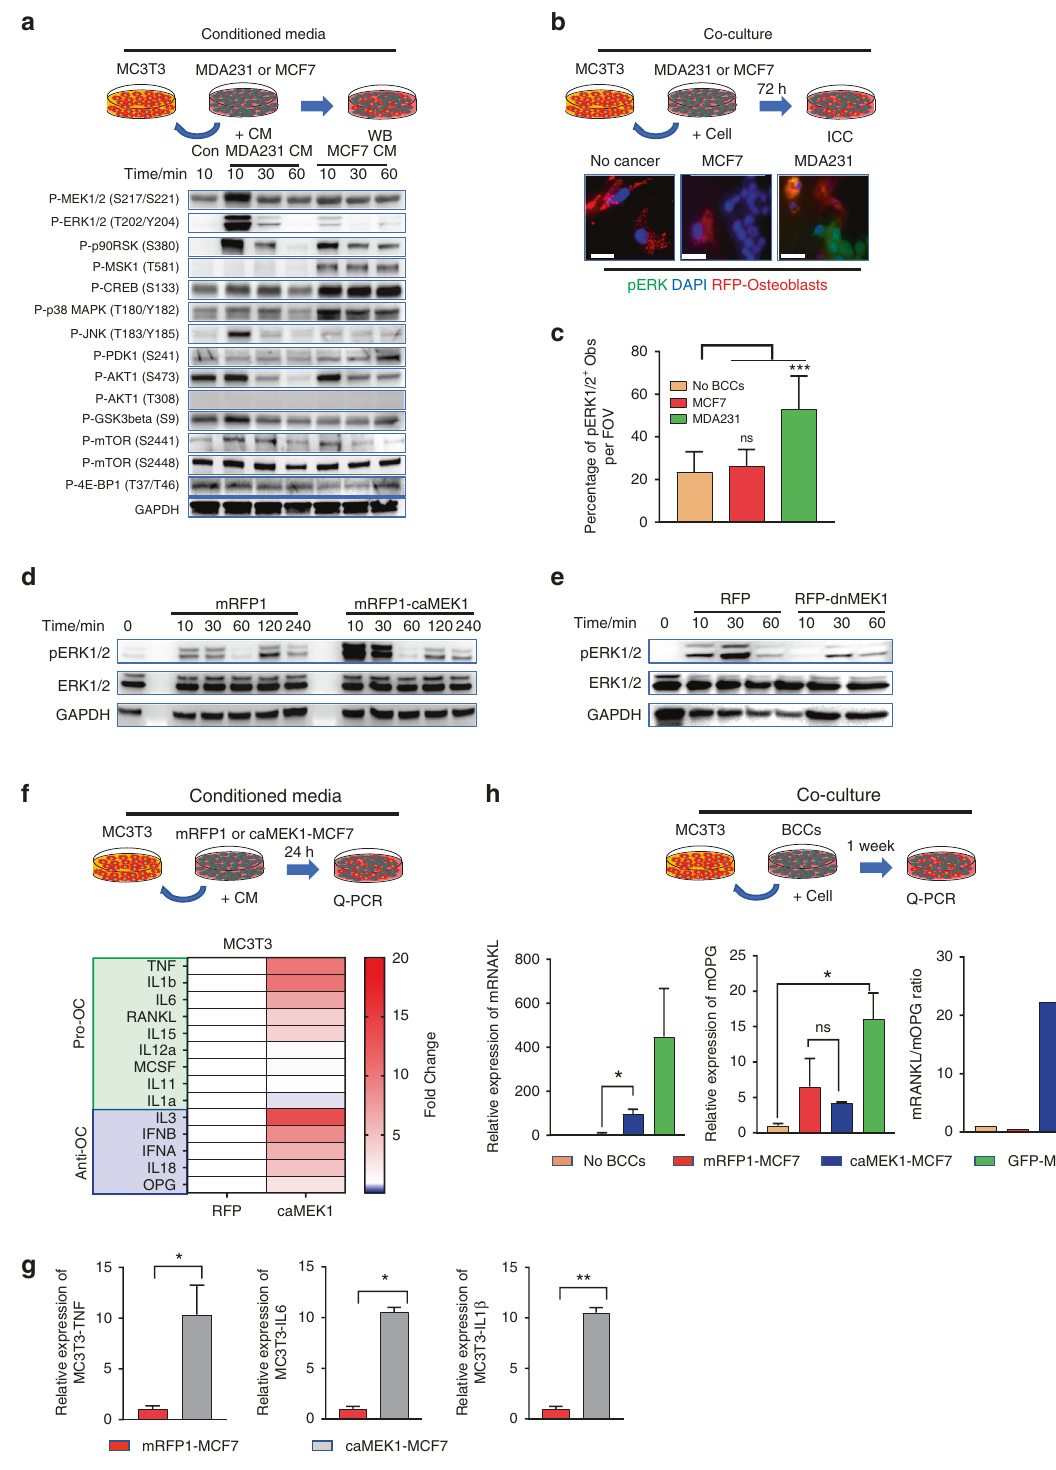
Fig. 2 pERK1/2-high BCCs promote the conversion of naïve Obs into Obs expressing osteoclastogenic cytokines. a Kinase activation level in MC3T3 cells through conditioned media (CM) derived from cancer cells. Conditioned media (CM) derived from pERK1/2-high MDA231 cells induced ERK1/2 activation in Obs. b MDA231 cells promote the conversion of pERK1/2-low MC3T3 cells to pERK1/2-high MC3T3 cells. c MDA231 breast cancer cells highly expressing pERK1/2 were observed to histologically promote the conversion of MC3T3 cells weakly expressing pERK1/2 into pERK1/2-high MC3T3 cells under coculture conditions. Statistical analysis was performed by one-way ANOVA with Dunnett ’ s multiple comparisons. d CM derived from caMEK1-MCF7 cells promoted ERK1/2 activation in MC3T3 cells. e Lower levels of ERK1/2 activation in MC3T3 cells were observed in the presence of CM derived from dnMEK1-MDA231 cells compared to mRFP1-MDA231-derived CM. f , g Activation of ERK1/2 in the caMEK1-MCF7-expressing cells promoted the phenotypic conversion of naïve Obs into osteoclastogenic cytokines expressing Obs. P values were calculated using Student ’ s two-tailed t test. h RANKL/OPG ratios of local Obs increased secondary to interactions with caMEK1-MCF7-expressive BCCs. P values were calculated using the two-tailed t